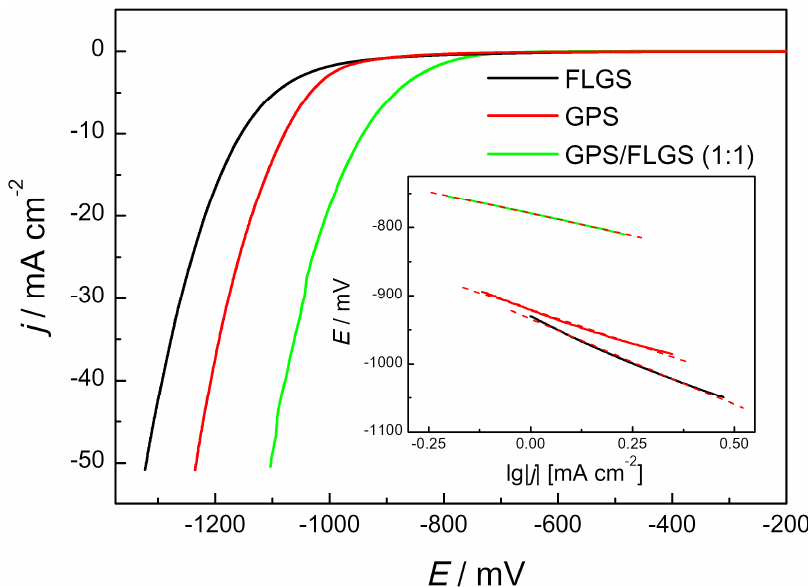
Figure 5. The hydrogen evolution reaction with different catalysts in an Ar-saturated 0.1 M KOH solution, v = 10 mV·s − 1 , and an electrode rotation rate of 2000 rpm. The inset shows the corresponding Tafel plots.